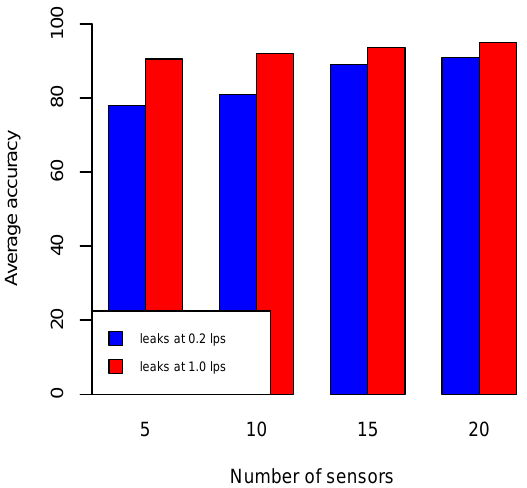
Figure 6. Performance of localizing single leaks at 0.2 lps and 1.0